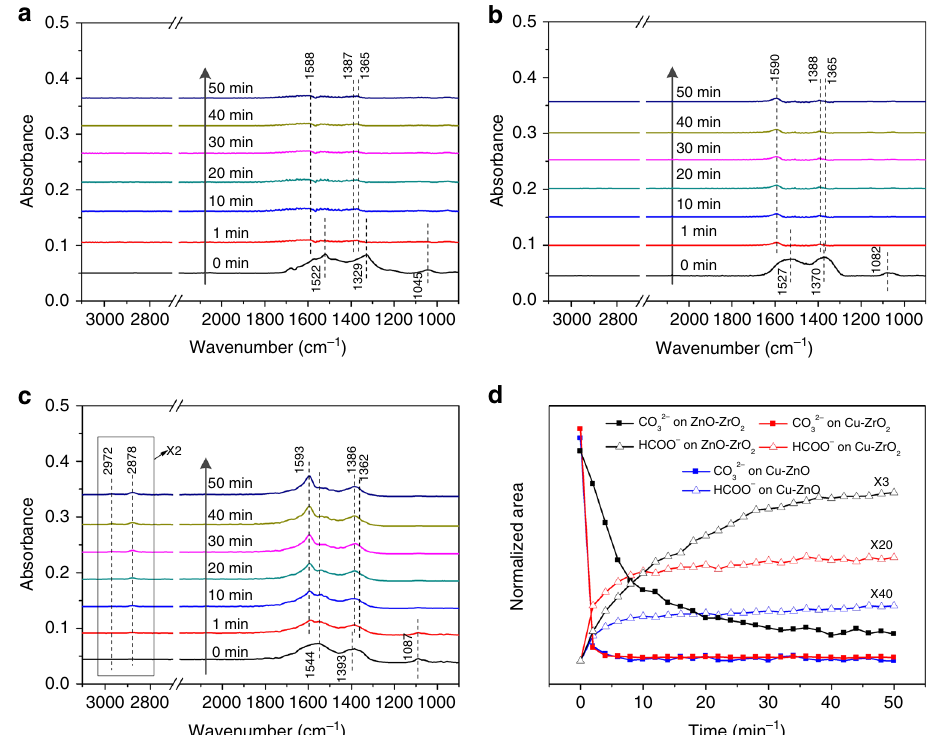
Fig. 3 Comparison on the surface species on Cu – ZnO, Cu – ZrO 2 , and ZnO – ZrO 2 systems in the designed conditions. a – c In situ DRIFT spectra over a Cu – ZnO, b Cu – ZrO 2 , and c ZnO – ZrO 2 materials at 493 K after switching feed gas from CO 2 (CO 2 has been loaded into the camber for 10min) to H 2 with a fl ow rate of 40mL/min under atmosphere pressure. d Peak areas of generated intermediate species during the experiments: areas normalized to the values observed at the end of the transient. Only the ZnO – ZrO 2 sample shows obvious formation of formate species (2972, 2878, 1593, 1386, and 1362cm − 1 ) from carbonate species when the feed gas was switched from CO 2 to H